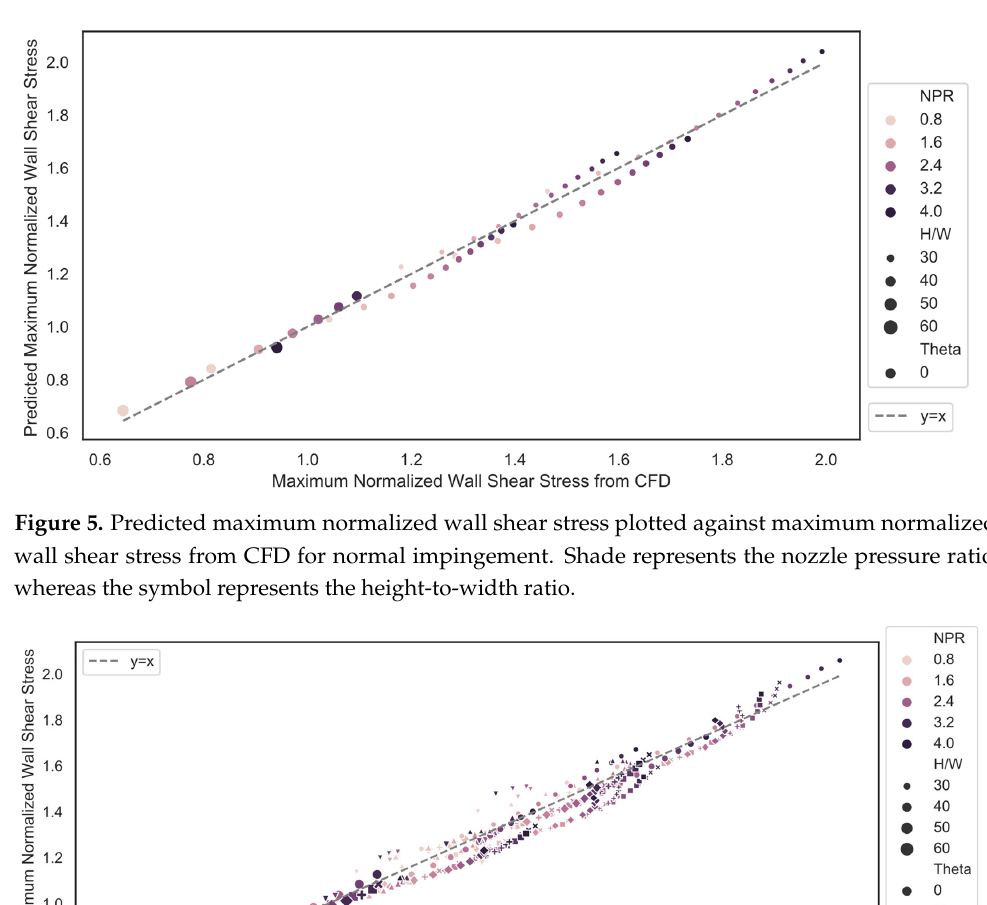
Figure 6. Predicted maximum normalized wall shear stress plotted against maximum normalized wall shear stress from CFD for all impingement angles. Shade represents the nozzle pressure ratio,